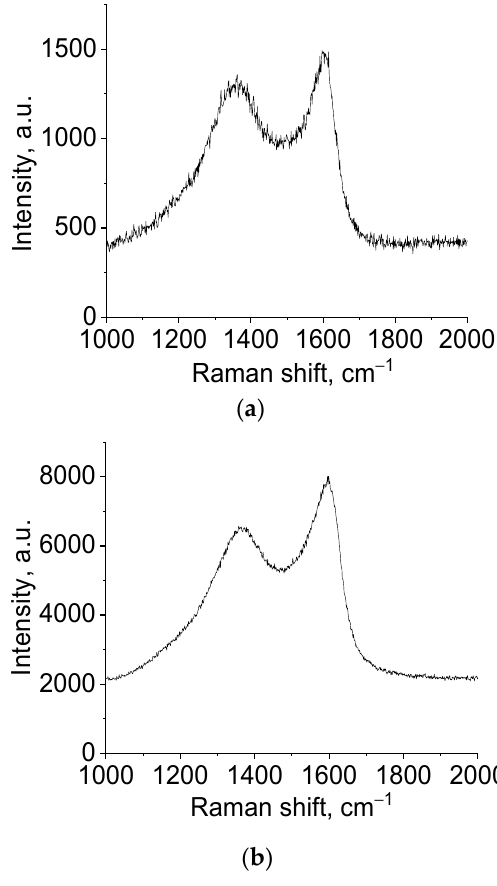
Figure 6. Raman spectra of a sample of molybdenum blue xerogels obtained using ( a ) glucose (G-7) and ( b ) hydroquinone (H-4) calcined at 900 ° C in inert N 2 atmosphere.